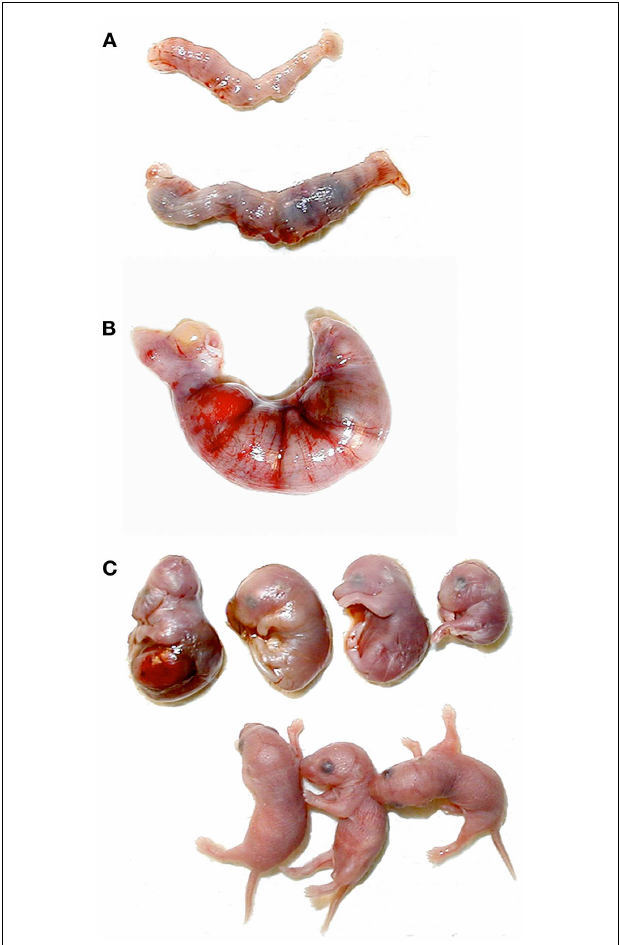
FIGURE 6 |Abnormal pregnancy outcomes in Clock mutant females . (A) Uteri removed from postpartum wildtype (top) and Clock/Clock (bottom) females.The dark regions in the Clock mutant uterus are reabsorbing fetuses. (B) Uterus removed from a Clock mutant female after 24h of dystocia. (C) Fetuses removed from the Clock/Clock uterus in (B) , shown with age-matched live fetuses from a wildtype dam (bottom).